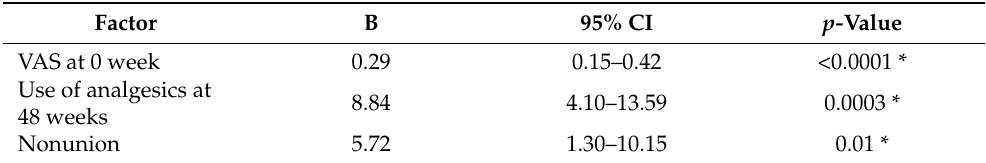
Table 3. Multiple regression analysis: independent factors contributing to low back pain at 48 weeks after